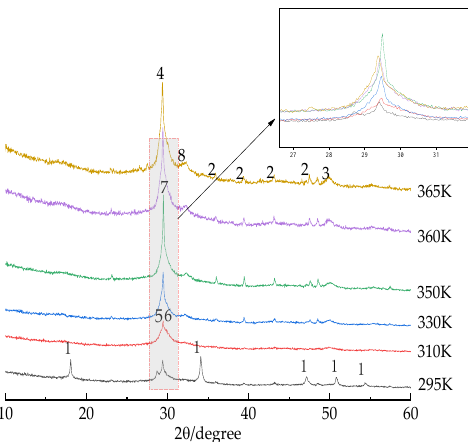
Figure 3. XRD patterns of the products at different temperatures. 1 — Ca(OH) 2 ; 2 — CaCO 3 ; 3 — CaO·SiO 2 ·H 2 O; 4 — 2CaO·SiO 2 ·1.7H 2 O; 5 — 5CaO·6SiO 2 ·5.5H 2 O; 6 — 5CaO·6SiO 2 ·3H2O; 7